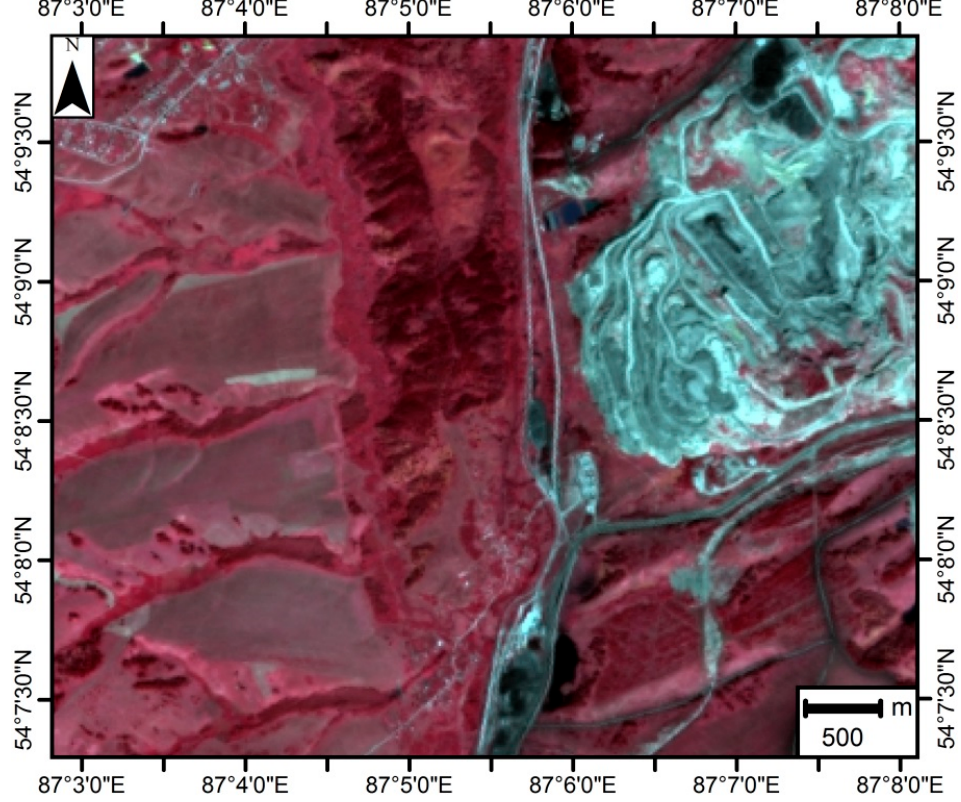
Figure 7. Landsat-8 pre-event imagery (14 September 2014) of the Russian mining waste site (NIR/Red/Green). The mining area (cyan) is free of vegetation. Landsat-8 © USGS 2014.